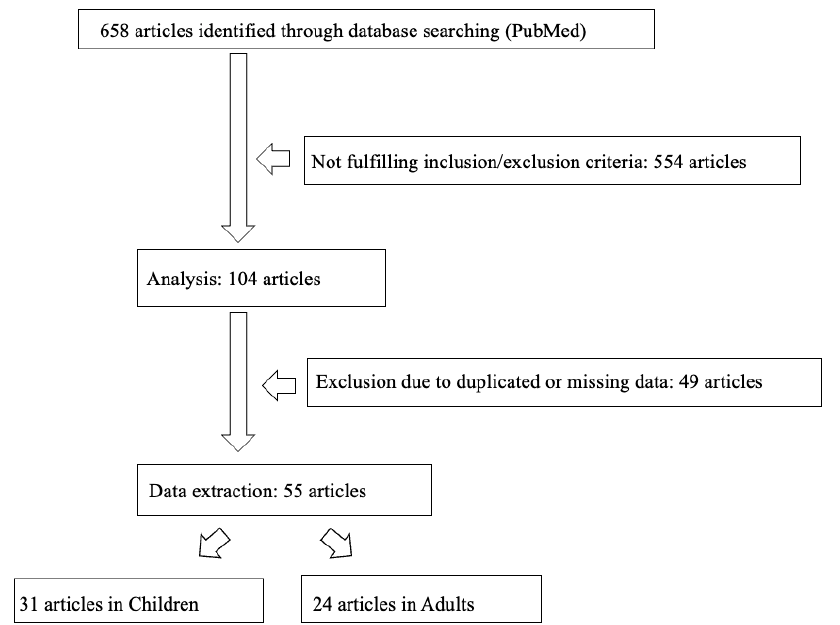
Figure 1. Flowchart of the literature search.